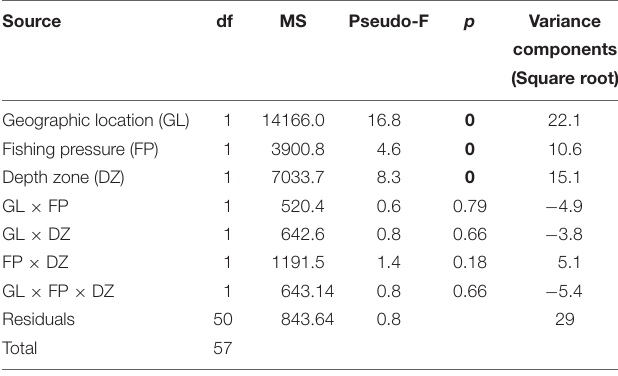
TABLE 5 | PERMANOVA results of rocky reef fish community structure in relation to geographic location, fishing pressure, and depth zone, based on square root transformed density data.